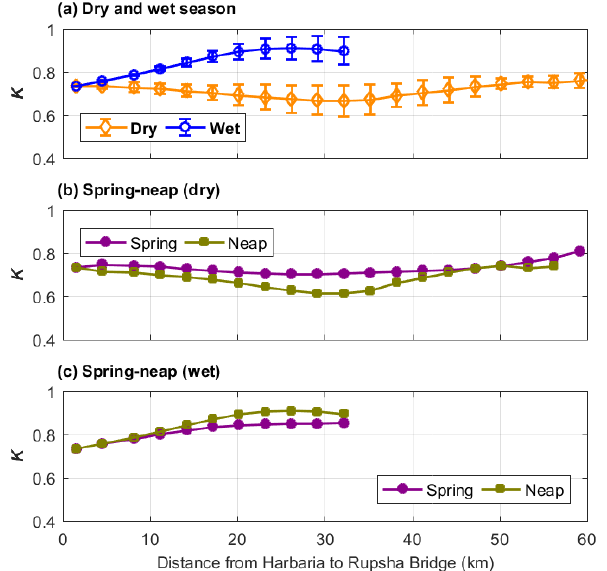
Figure 5. Spatial variation of Van der Burgh’s coefficient ( K) along the Pasur River estuary. If K <0.3, up-estuary salt transport is en- tirely dominated by tide-driven mixing. If K >0.8, up-estuary salt transport is almost entirely dominated by gravitational circulation. If 0.51< K <0.66, the dispersion is proportional to the longitudinal density gradient.